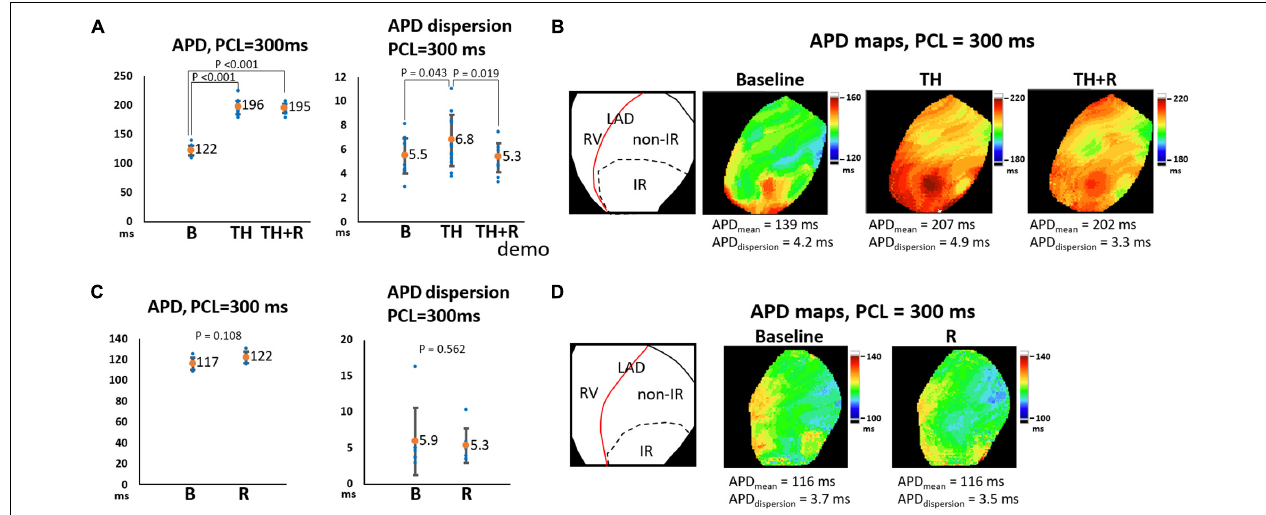
FIGURE 2 | Effects of therapeutic hypothermia (TH) and rotigaptide (R) on action potential duration (APD) and APD dispersion (APD dispersion ) at pacing cycle length (PCL) of 300 ms. (A,C) Summarized results of APD and APD dispersion in the TH ( n = 14, repeated-measures ANOVA with post hoc LSD analysis) and non-TH groups ( n = 7, Student’s t -test), respectively. Numbers indicate the mean values of APD (APD mean ). TH significantly prolonged APD and increased APD dispersion , which were attenuated by rotigaptide. (B,D) Representative APD 80 and APD dispersion maps in the TH and non-TH groups, respectively. IR, ischemia–reperfusion; LAD, left anterior descending artery; RV, right